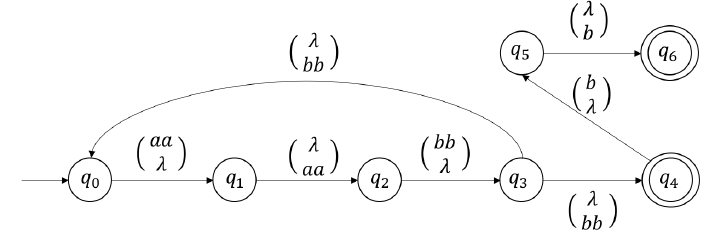
Figure 4. A simple WKFA with initial delays equal to